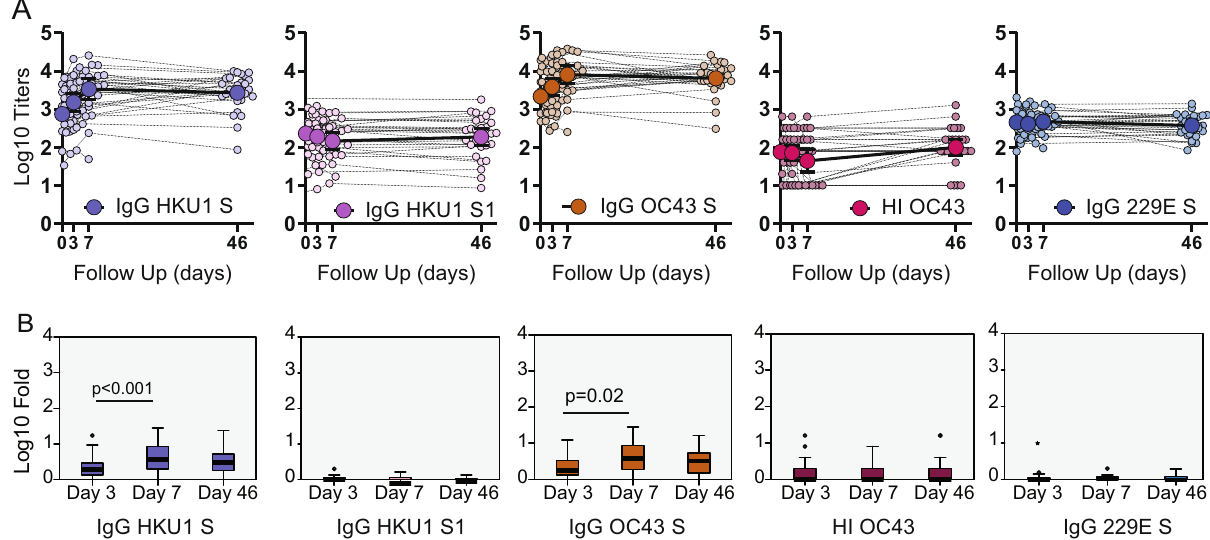
Fig. 3 Longitudinal antibody response to selected seasonal human coronaviruses antigens. Serum from hospitalized COVID-19 patients was analyzed at baseline, at hospital recruitment and days 3 and 7. A subsequent sample was collected in the convalescence period in the COVID-19 survivors with mean time of 46 days. A Longitudinal pro fi le of antibodies against betacoronavirus (HKU1 and OC43) and alphacoronavirus (229E) antigens. Antibody titer was quanti fi ed as area under the curve (AUC) after serial serum dilution for each sample (Supplementary Fig. 1). Calculated AUC at each time is shown to quantify changes over time for each individual (small dots) against immunoglobulin G (IgG) HKU1 spike, IgG HKU1 S1, IgG OC43 spike and IgG 229E. Geometric mean titer (GMT, big dots) and con fi dence interval (CI 95%) are also shown. Hemagglutination inhibition (HI) assay were also performed for OC43 and GMT of end point titers are shown at each time point. B Boxplot diagram of geometric mean fold rise (GMFR) antibody titers against seasonal coronaviruses at the same time points: IgG HKU1 spike, IgG HKU1 S1, IgG OC43 spike and IgG 229E; and HI titer. Related-samples Friedman ’ s two-way ANOVA was performed. Signi fi cant adjusted p values after pairwise comparisons are shown for each comparison. Black bar indicates GMFR values, box indicates IQR (Q1 – Q3), lines indicate minimum and maximum. Outliers from the observed distribution are shown. Total n = 116 biologically independent serum samples (day 0 = 37, day 3 = 29, day 7 = 22, day 46 = 28). n = 116 biological samples examined against four different seasonal coronavirus substrates for ELISA assays; ELISAs for each substrate were run once each. N = 116 serum samples examined over two independent experiments for hemagglutination